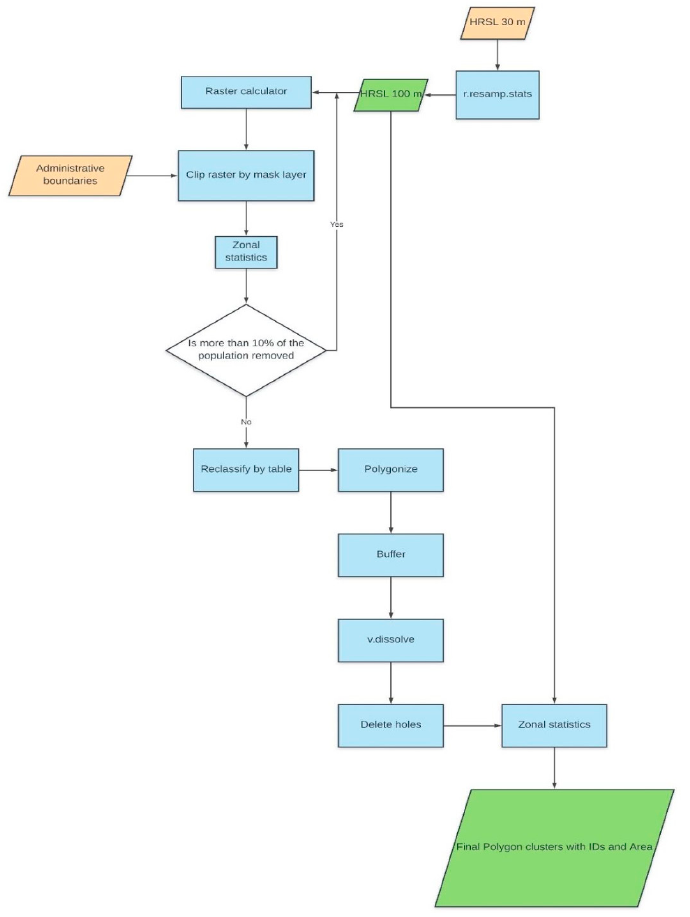
Figure A1. Methodological flowchart of creating population clusters using the High Resolution Settlements Layer and Geographic Information Systems processing.